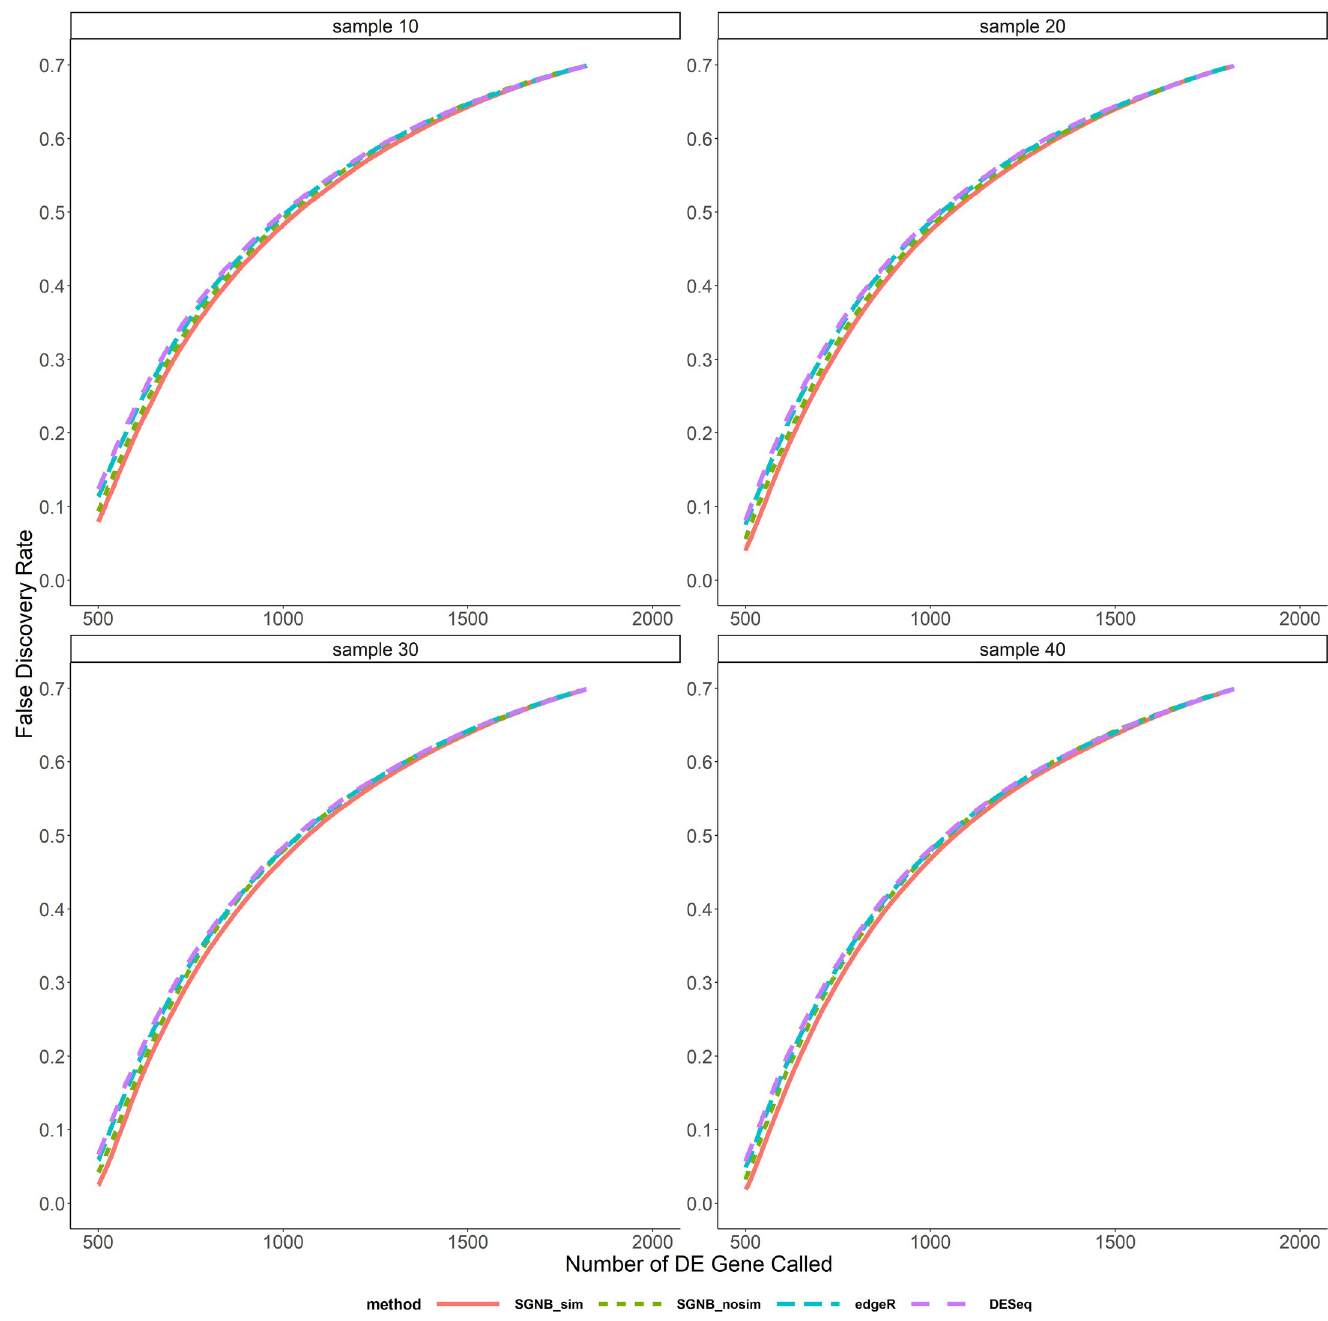
Fig 6. False discovery rate vs. number of DE gene called with small dispersion.